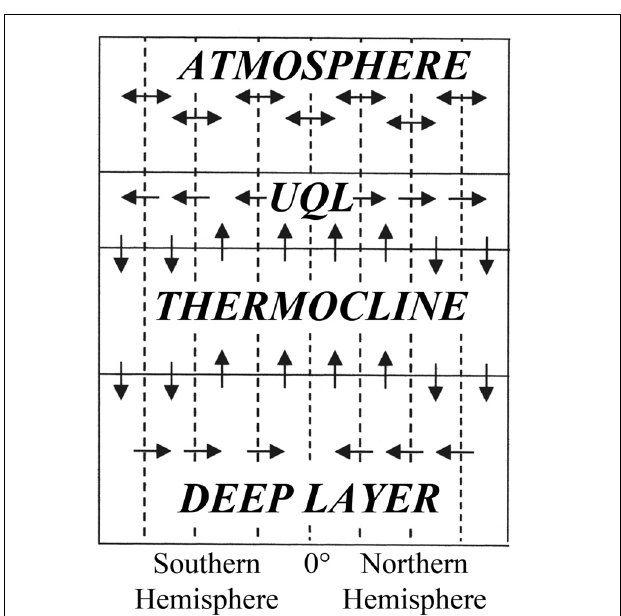
FIGURE 4 | The scheme of the global carbon cycle (GPP, gross primary productivity; NPP, net primary productivity; NEP, net